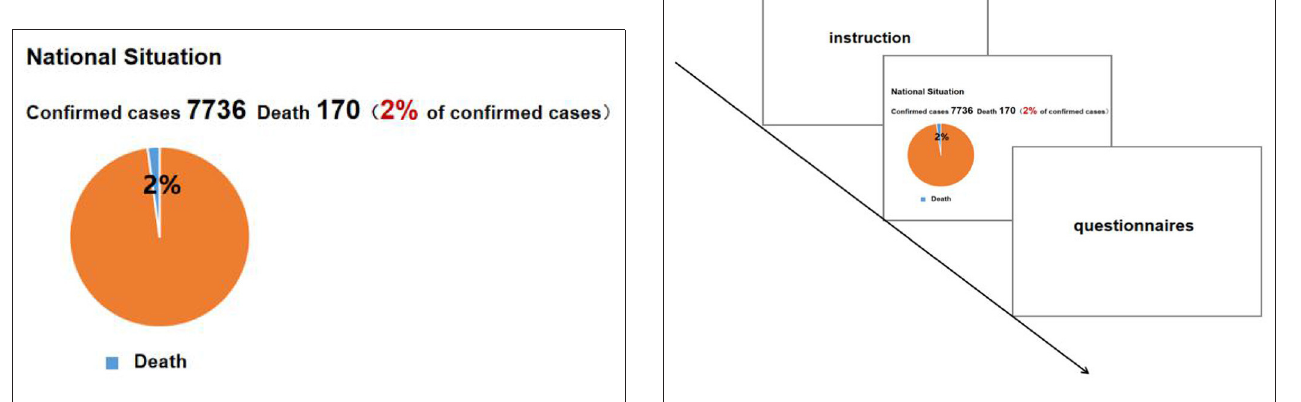
FIGURE 1 | The illustration of innovative priming information. FIGURE 2 | The procedure of Experiment 1 and Experiment